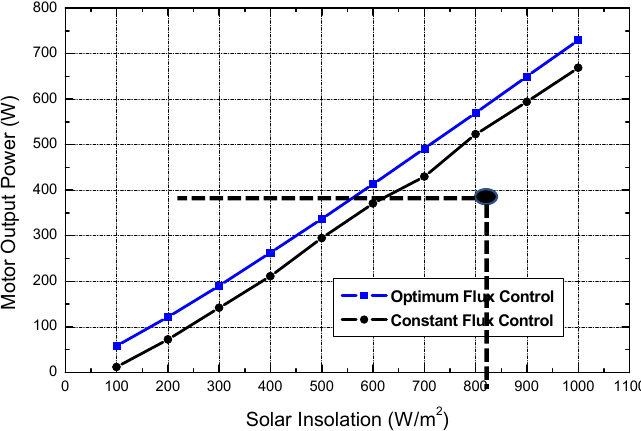
Figure 11. Motor output power at 25 °C with variable insolation.